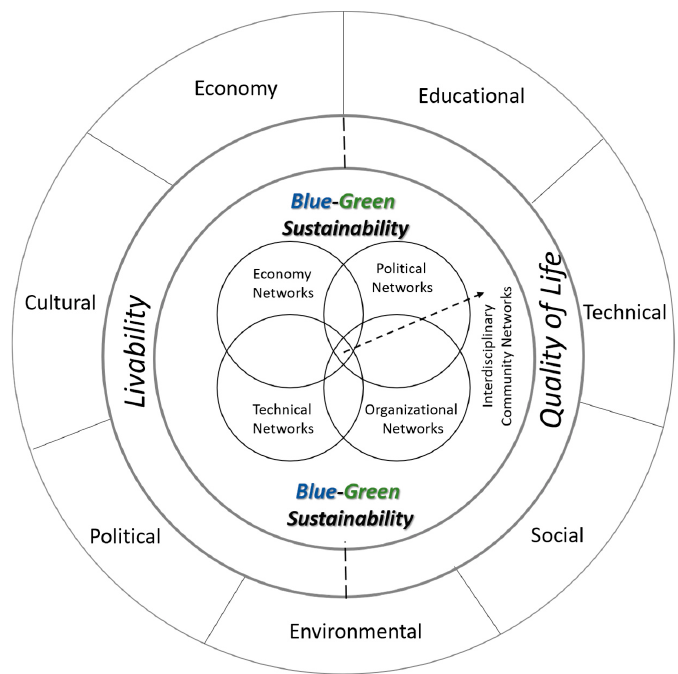
Figure 9. 5N.BG.7PS Model.